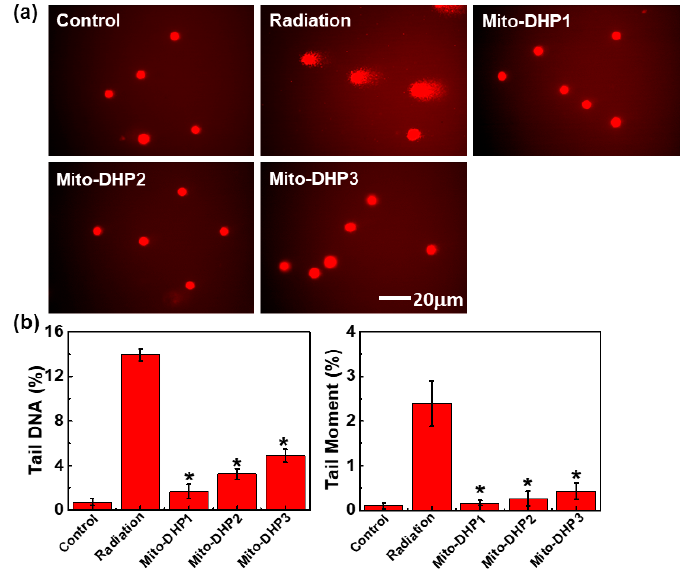
Figure 4. Comet assay demonstrated DNA damage in CHO-K1 cells after 3Gy γ -radiation. ( a ) Comet images from Mito-DHPs treated and untreated groups. Cells from radiation groups displayed clear tail trailing, whereas tail trailing in Mito-DHPs-treated groups was at a similar level compared with the non-irradiated control group; ( b ) Tail DNA (%) and Tail Moment (%) representing nuclear DNA damage following a 3 Gy radiation dose. These parameters are markedly reduced in cells pretreated with Mito-DHPs (* p < 0.05).